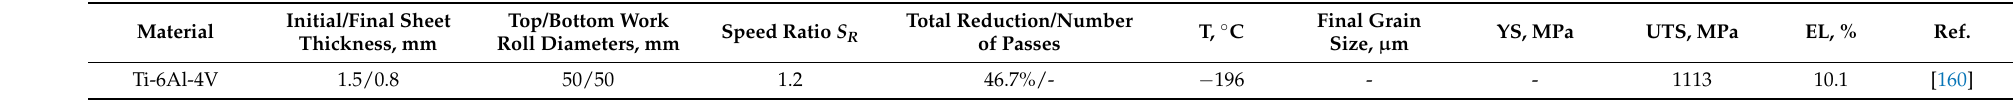
Table 11. Experimental data related to asymmetric cryorolling of Ti